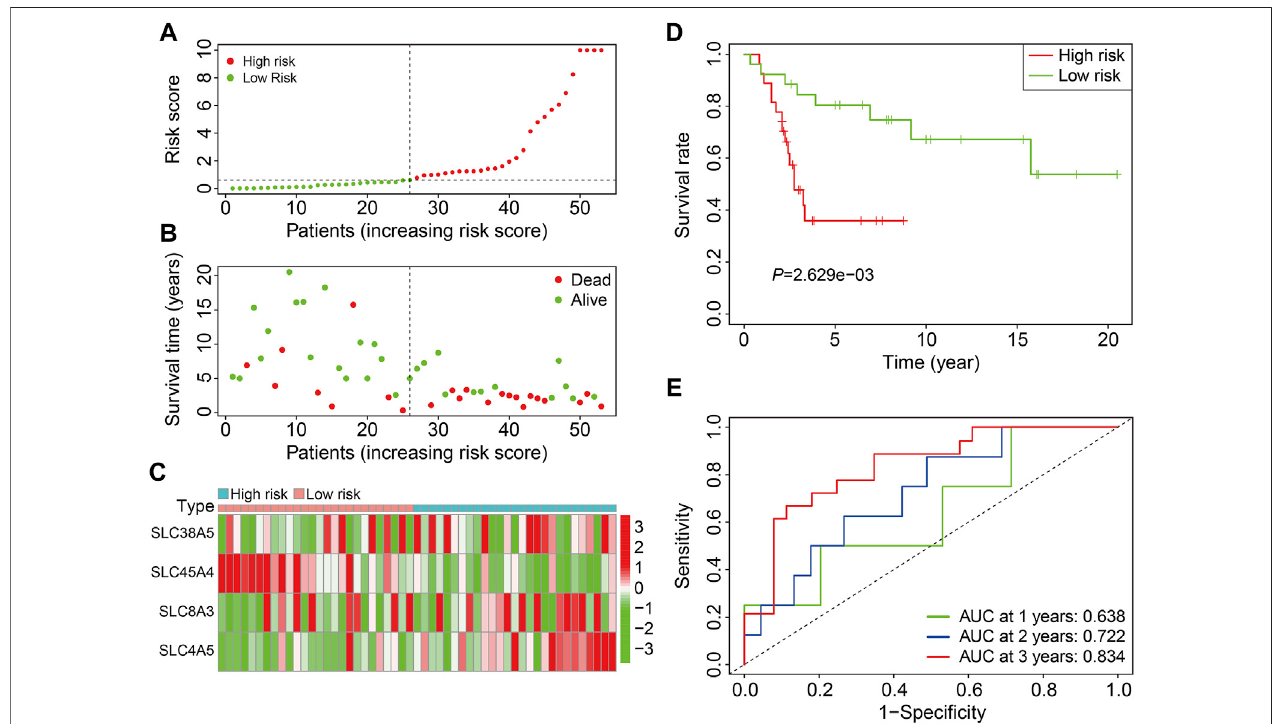
FIGURE4| ValidationoftheSLCgenesignatureinGSE21257cohort. (A) Distributionofpatients ’ riskscoreinGSE21257cohort. (B) Distributionofsurvivalstatus and survival time of patients in GSE21257 cohort. (C) The expression pro fi le of the four SLC genes in GSE21257 cohort. (D) Kaplan-Meier survival curves. (E) Time- dependent receiver operating characteristic curve analysis for the signature in external GSE21257